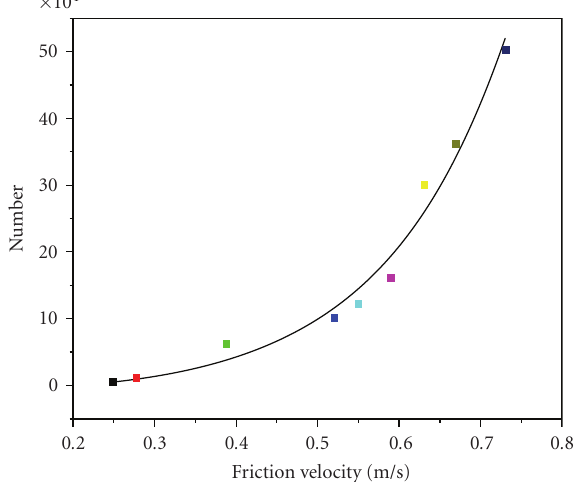
Figure 8: Ejected grain number versus friction